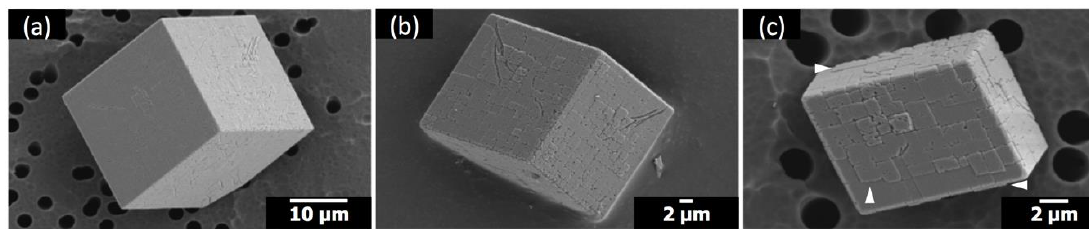
Figure 4. SEM images of the calcite crystals formed with Sr(II) and without polymeric additives: ( a ) Sr/Ca = 1:100; ( b ) Sr/Ca = 1:50; ( c ) Sr/Ca = 1:25. ( a ) Sr / Ca = 1:100; ( b ) Sr / Ca = 1:50; ( c ) Sr / Ca = 1:25.